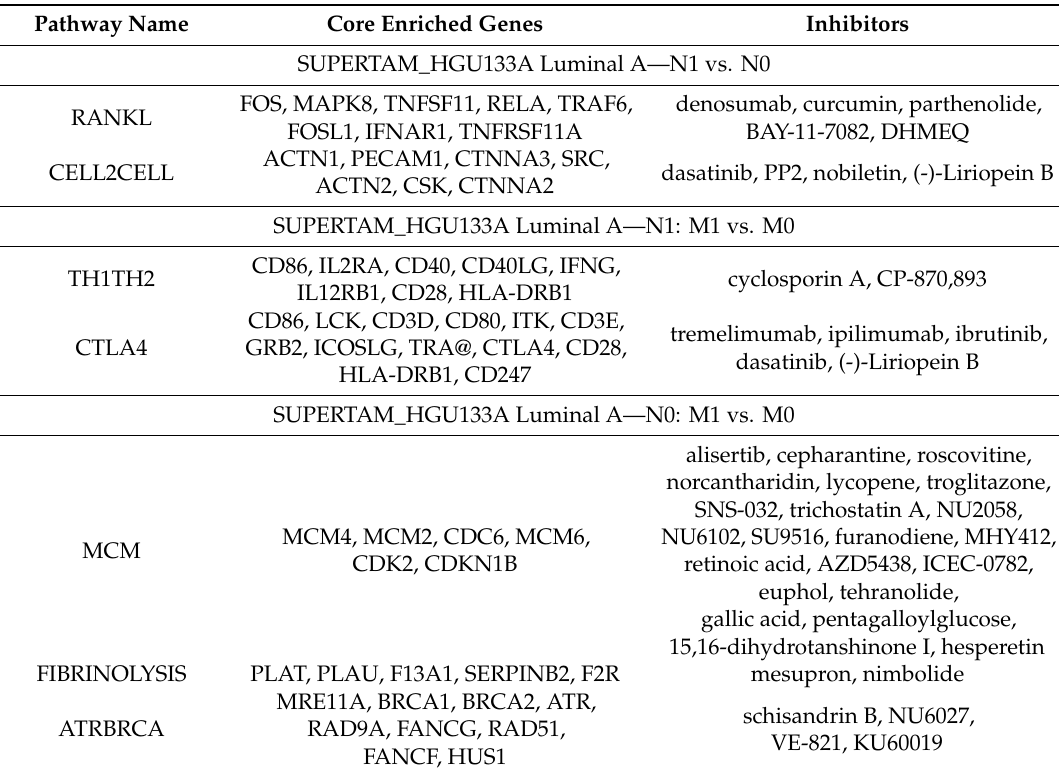
Table 2. BIOCARTA pathways (NOM p -value < 0.05) significantly enriched in luminal A primary tumors in SUPERTAM_HGU133A dataset including core enriched genes and their inhibitors.